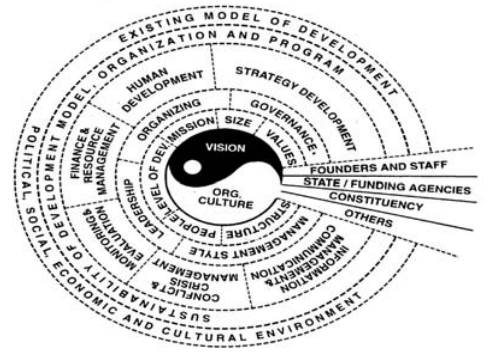
Figure 2: Chakra